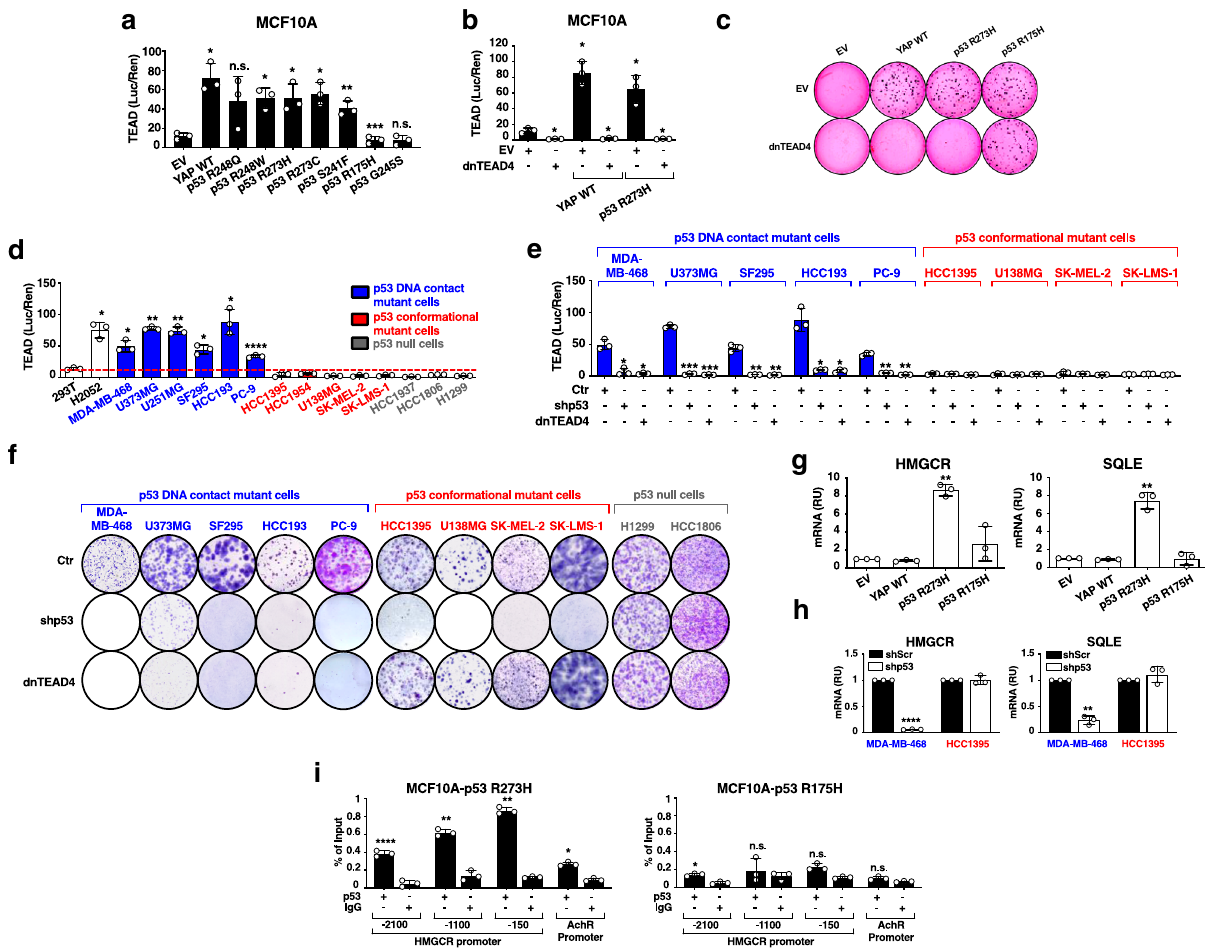
Fig. 1 P53 DNA contact mutations drive TEAD/YAP dependent transcription/transformation in human tumors through MVA pathway activation. a TEAD reporter activity of MCF10A cells stably expressing empty vector (EV) control, YAP WT, p53 R248Q, p53 R248W, p53 R273H, p53 R273C, p53 RS241F, p53 R175H, or p53 G245S. b TEAD reporter activity of MCF10A cells stably expressing EV control, YAP WT or p53 R273H in the presence or in the absence of dnTEAD4 stable expression. c Representative image from n = 2 biologically independent replicates showing anchorage-independent growth in soft agar of MCF10A cells stably expressing EV control, YAP WT or p53 R273H in the presence or in the absence of dnTEAD4 stable expression. d TEAD reporter activity of human tumor lines containing hot spot p53 DNA contact (in blue), conformational (in red), or null (in gray) mutations as speci fi ed in Supplementary Table 1. 293T (wt p53) and H2052 cells (wt p53 and NF2; LATS2 LOFs) served as negative and positive controls, respectively. e TEAD reporter activity of indicated tumor lines stably expressing empty vector control (Ctr), dominant negative TEAD4 (dnTEAD4) or p53 shRNA (shp53). f Representative plates from n = 2 biologically independent replicates showing 2D colony formation by indicated tumor lines stably expressing empty vector control (Ctr), dnTEAD4 or shp53 for 14 days. g mRNA expression levels of MVA pathway genes, HMGCR and SQLE, by real time PCR in MCF10A cells stably expressing EV control, YAP WT, p53 R273H or p53 R175H. h mRNA expression of Mevalonate (MVA) pathway genes, HMGCR and SQLE, by real time PCR in the indicated cell lines stably expressing Scramble shRNA (shScr) or shp53. i ChIP analysis on HMGCR promoter in MCF10A cells stably overexpressing either p53 R273H or p53 R175H. ChIP was performed with p53 or control immunoglobulin G (IgG) antibody and quanti fi ed by real-time PCR on the indicated promoters. Acetyl choline receptor (AchR) promoter was used as a negative control. p values were derived using two tailed t -tests from means± SD of n = 3 biologically independent replicates.* p < 0.05, ** p < 0.01, *** p < 0.001, **** p < 0.0001. Source data with actual calculated p values are provided as Source data fi